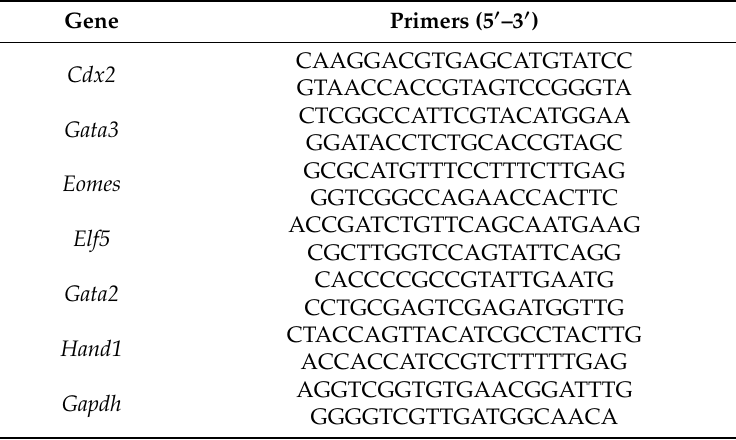
Table 2. Details of PCR primers used in this